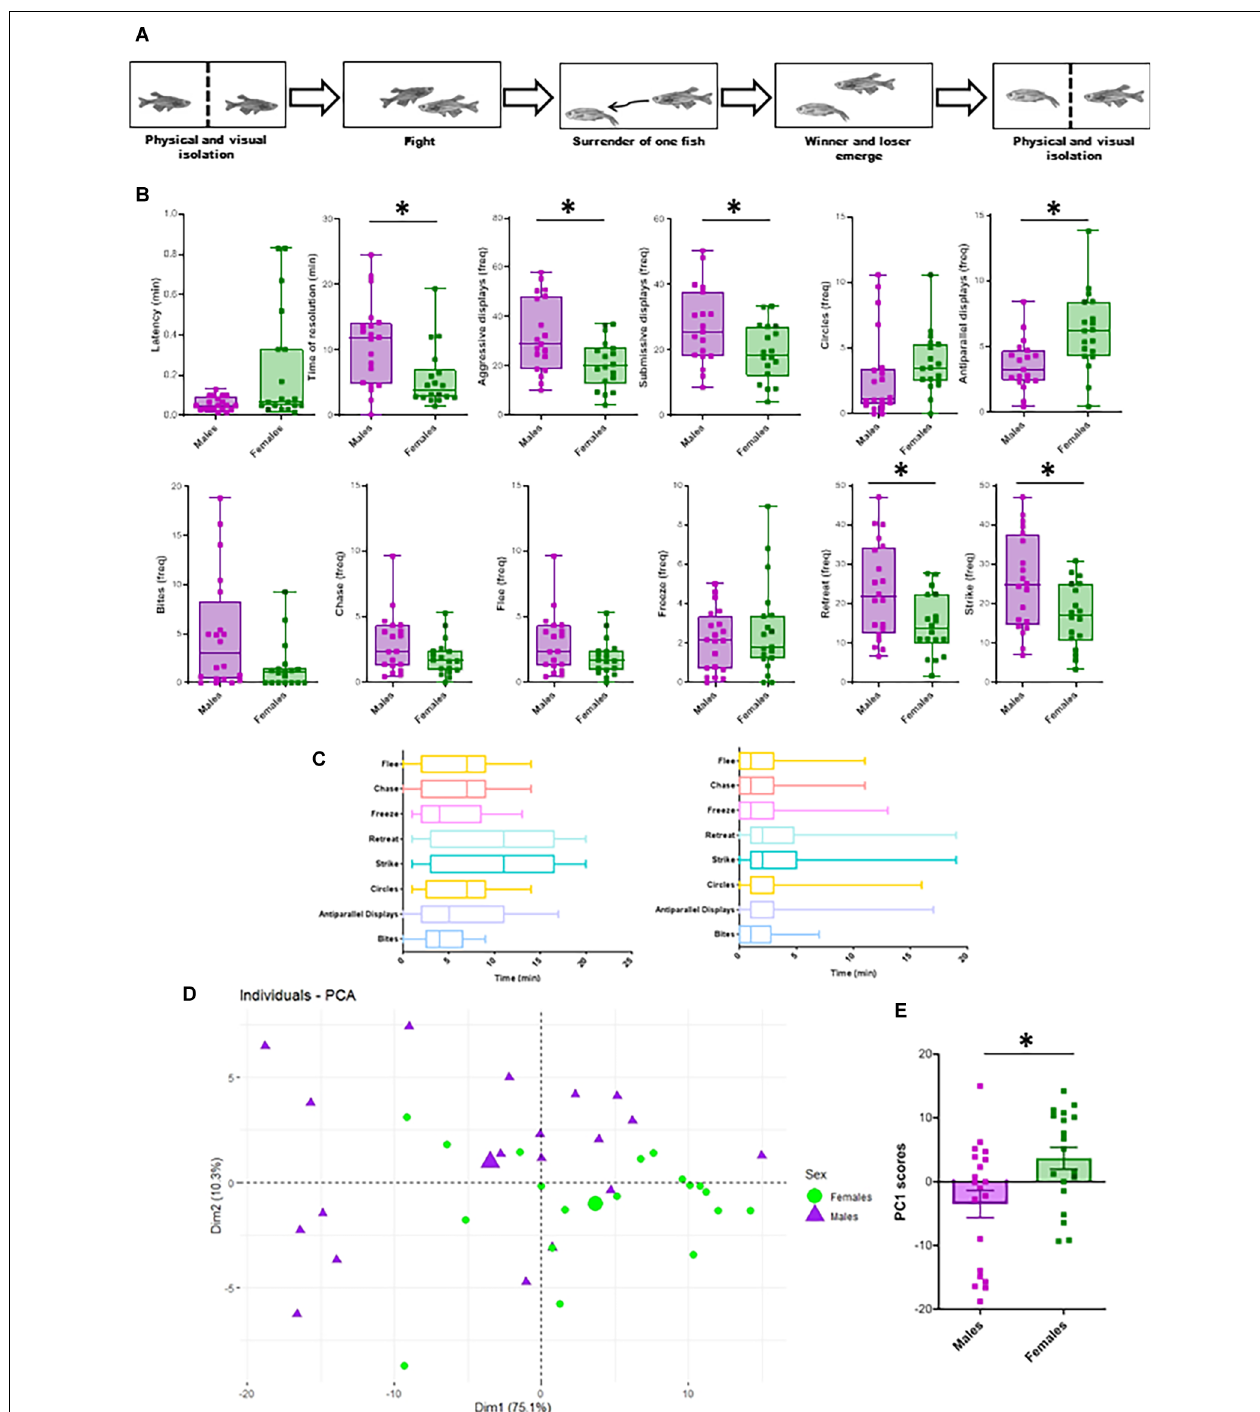
FIGURE 1 | Sex differences in aggressive behavior. (A) Schematic illustration of experimental protocol for zebrafish fighting. After overnight physical and visual isolation, sex-matched dyads perform agonistic behaviors until one of the fish surrenders. After winner and loser determination, both opponents were isolated again until tissue collection. (B) Sex differences in behavioral parameters. Latency and time of resolution are expressed in minutes. The frequency of each agonistic behavior is calculated as the number of each behavioral display, divided by the duration of the encounter until conflict resolution. Aggressive behaviors include antiparallel displays, circles, bites, chases and strikes, while submissive behaviors include freeze, flee, and retreats (Oliveira et al., 2011). Box plots were used to plot the data: the box extends to the furthest data points within the 25th and 75th percentile, and whiskers extend to the furthest data points not considered